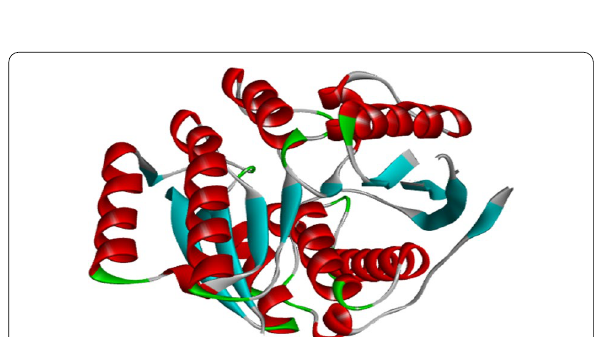
Fig. 4 3D structure of prepared receptor